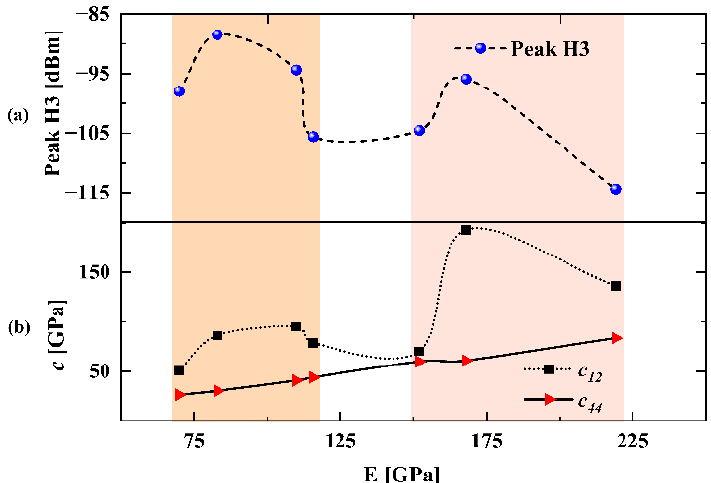
Figure 8. ( a ) Simulated H3 peak magnitude of the SAW resonators with different electrode materials. ( b ) Elastic constants of different electrode materials arranged in ascending order of Young’s modulus.